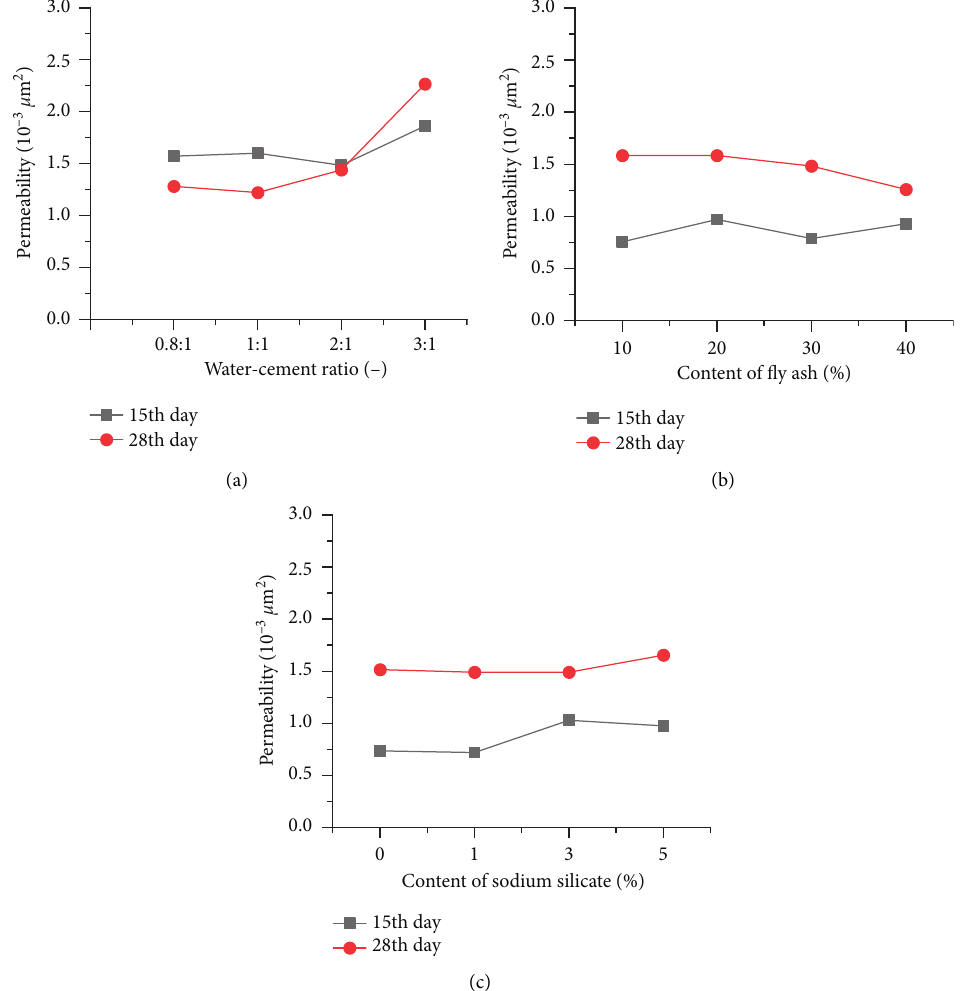
Figure 3: Measured permeability at different (a) water-cement ratios, (b) fly ash contents, and (c) sodium silicate contents.